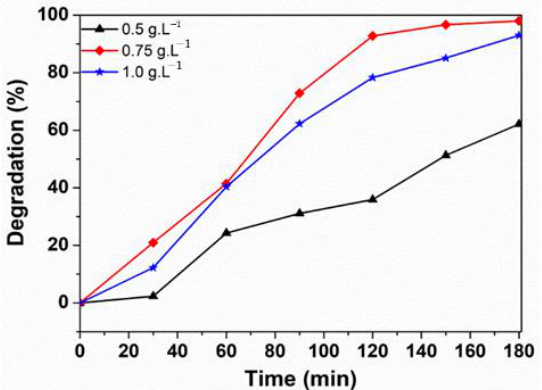
Figure 11. The effect of ZnNd 0.03 Fe 1.97 O 4 dosage on the degradation of Rhodamine.